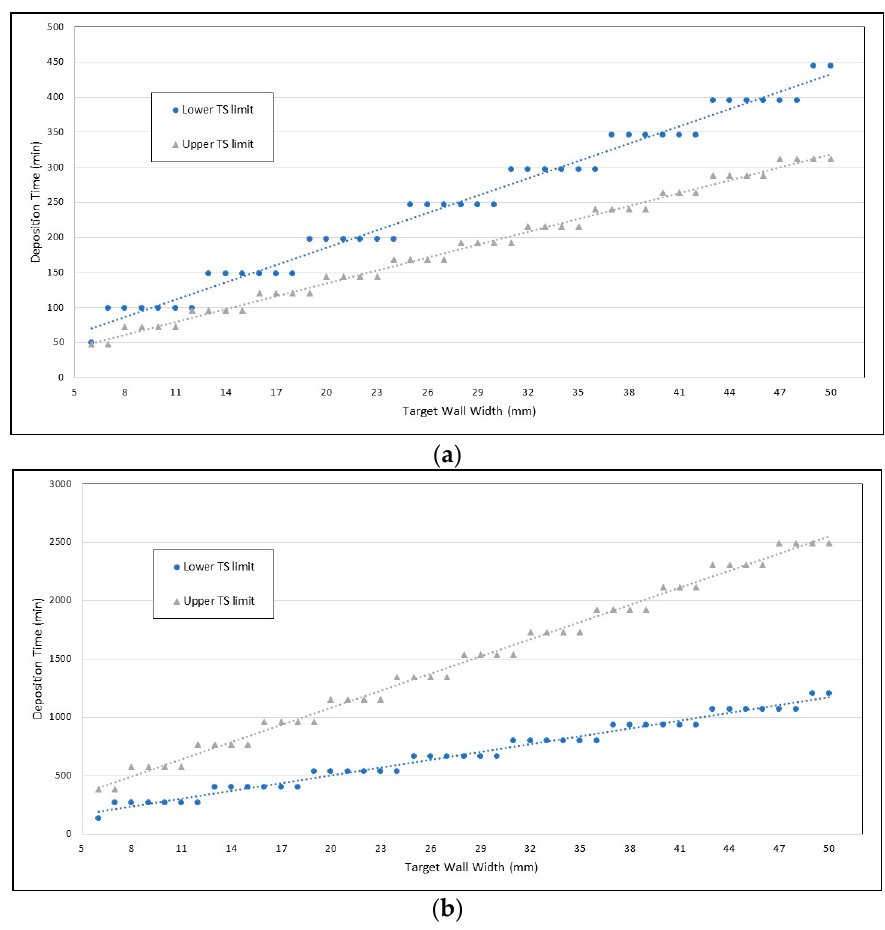
Figure 13. Estimated time spent for WAAM production of aluminum multilayer walls of 100-mm high and 500-mm long as a function of the target wall thickness (from 6–50 mm), by using the lower and upper travel speed limits found in Section 2.1: ( a ) no dead time between subsequent layers are accounted; and ( b ) a 120 s dead time between subsequent layers are accounted.